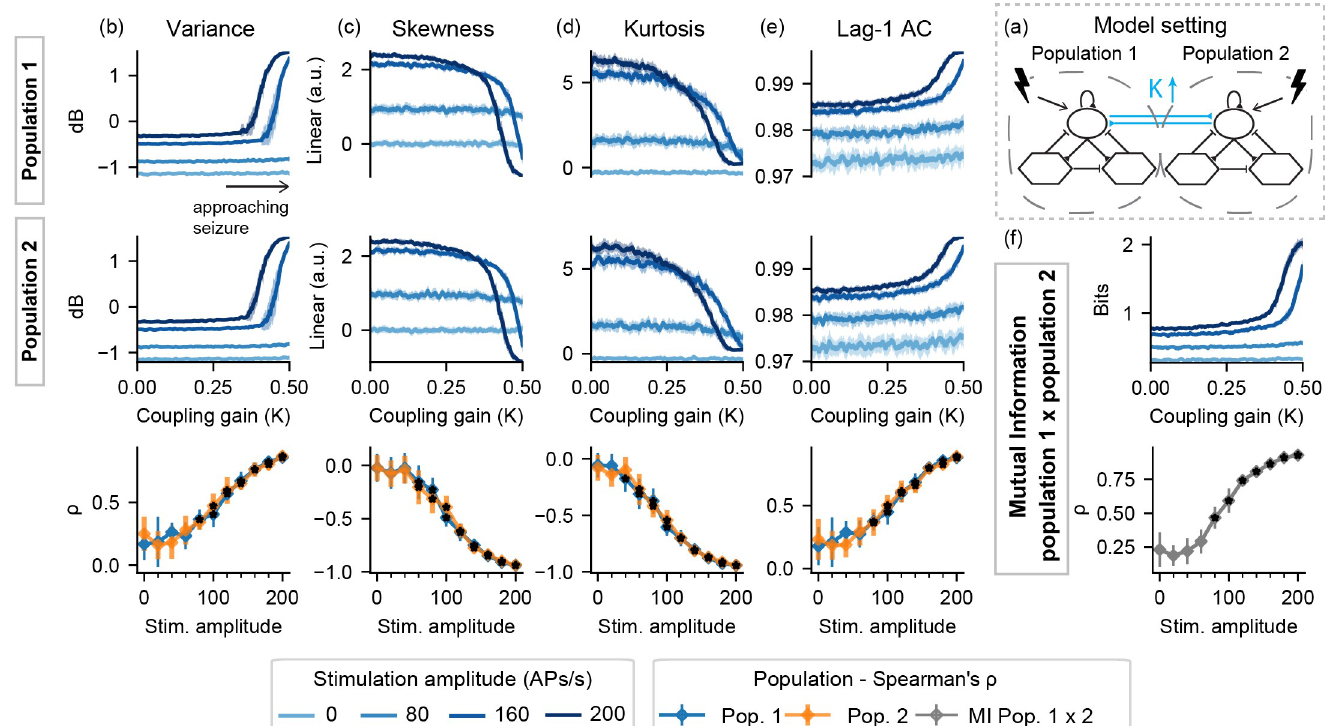
Fig 8. Feature series and probing efficiency for model setting II-K. Probing provides predictive value for both stimulated populations. (a) shows a simplified illustration of the model setting. For (b) variance, (c) skewness, (d) kurtosis and (e) lag-1 AC features, top rows show feature values extracted from the output of each population, as the coupling gain parameter (K) is increased. (f) shows the inter-population synchronization as measured by the mutual information feature. Bottom row shows Spearman’s rank correlation between each feature series and the shifted parameter (K), as stimulus amplitude is increased.